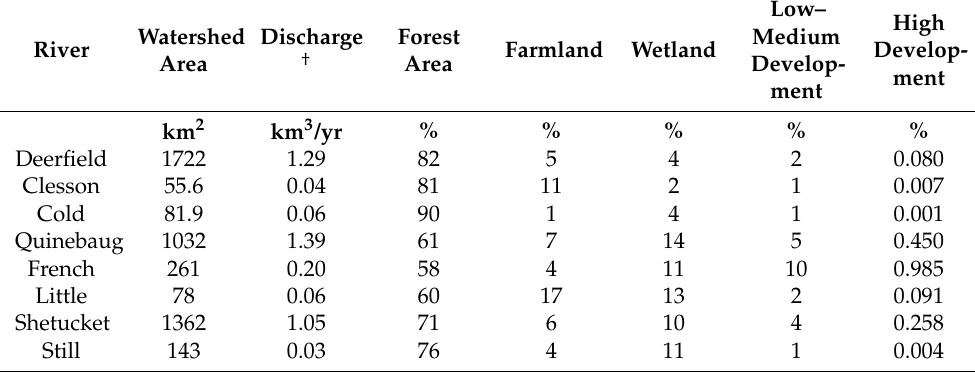
Table 1. River water samples were analyzed using a Hach SensIon+ portable meter for pH, oxidation- reduction potential, and electrical conductivity (Hach, Loveland, CO, USA). The remaining subsample was acidified to pH using HCl and analyzed for non-particulate dissolved organic carbon (DOC) using a TOC-L Shimadzu total carbon analyzer. Blanks were below detection (<0.01 mg/L), duplicates were within 2% CV, and spike recoveries were 92–103%. Watershed and subwatershed